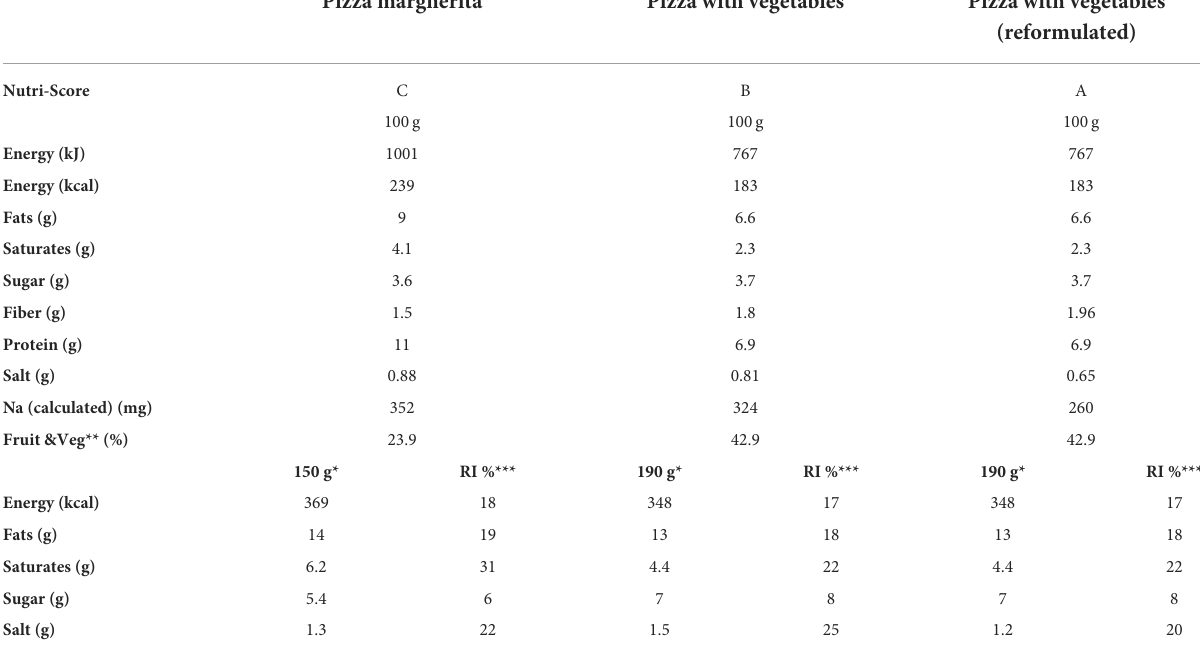
TABLE 6 Energy and nutrient content per 100g and per portion * of different formulated pizza sold on the Italian market, their Nutri-Score and percentage contribution of each portion declared by the manufacturer to Reference Intakes (RI %) (as in NutrInform Battery). Pizza margherita Pizza with vegetables Pizza with